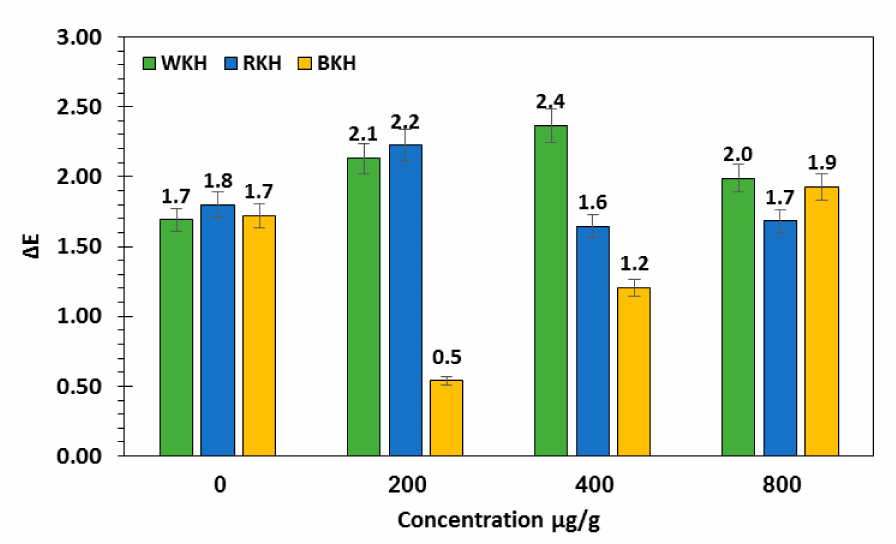
Figure 6. Total color change ( ∆ E) of meat samples supplemented with kidney bean hydrolysates during storage period. Table 8. Sensory properties of cooked chicken meat supplemented with black, red, and white kidney bean protein hydrolysate (BKH, RKH, and WKH) obtained by 30 min Alcalase hydrolysis, at 0 and 30 days cold storage at 4 ◦ C. Storage (Day) Sample Concn ( µ g/g) Tenderness Juiciness Taste Aroma Overall Acceptability Cont.